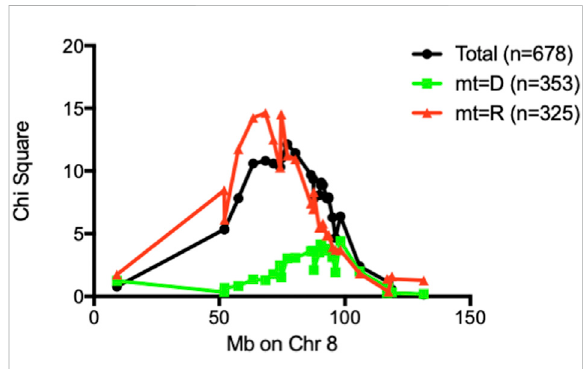
FIGURE 5 Chi-square values of each marker on Chr 8 were plotted against marker position in Mb. When strati fi ed by mt-genome, the linkage existed only when mt-genome is ALR derived mt-Nd2 a . Black line: Whole population of F2 ( n = 678); Red line: population of F2 mice with ALR-derived mt-Nd2 a ( n = 325); Green line: population of F2 mice with NOD-derived mt-Nd2 c ( n = 353).